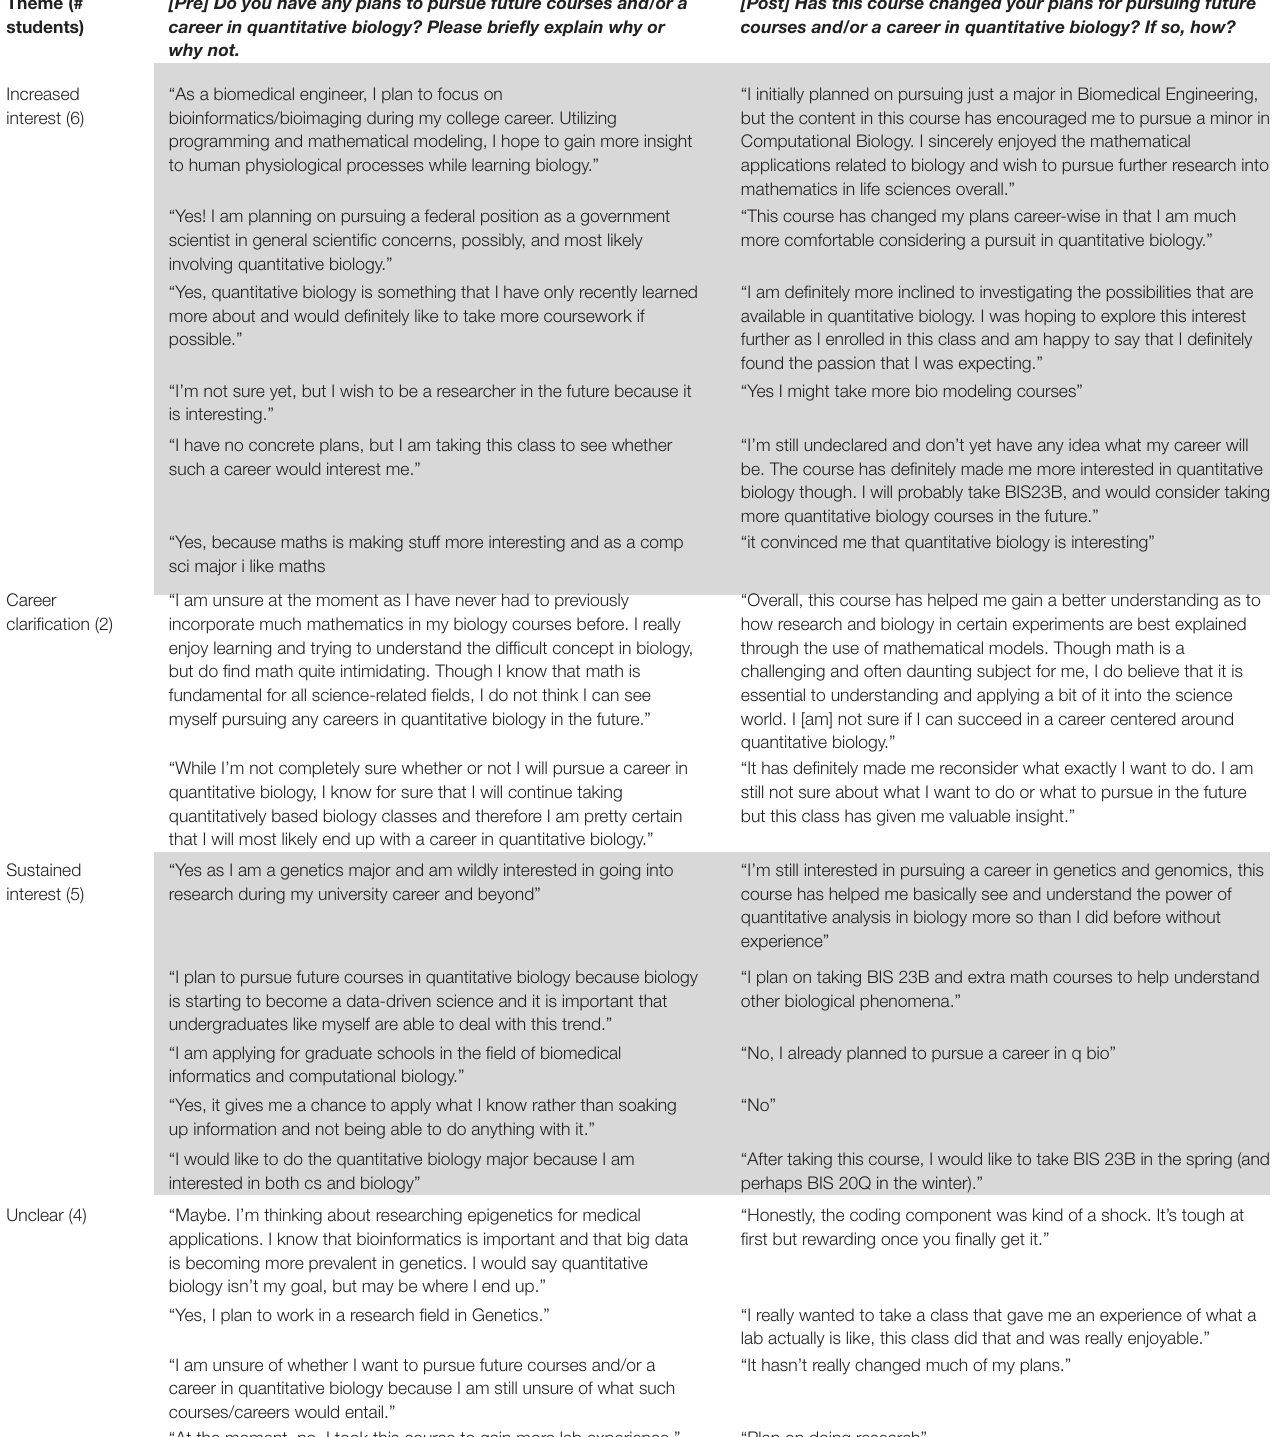
TABLE 3 | Summary of student responses to the short-answer survey questions about future academic plans related to quantitative biology. Theme (#